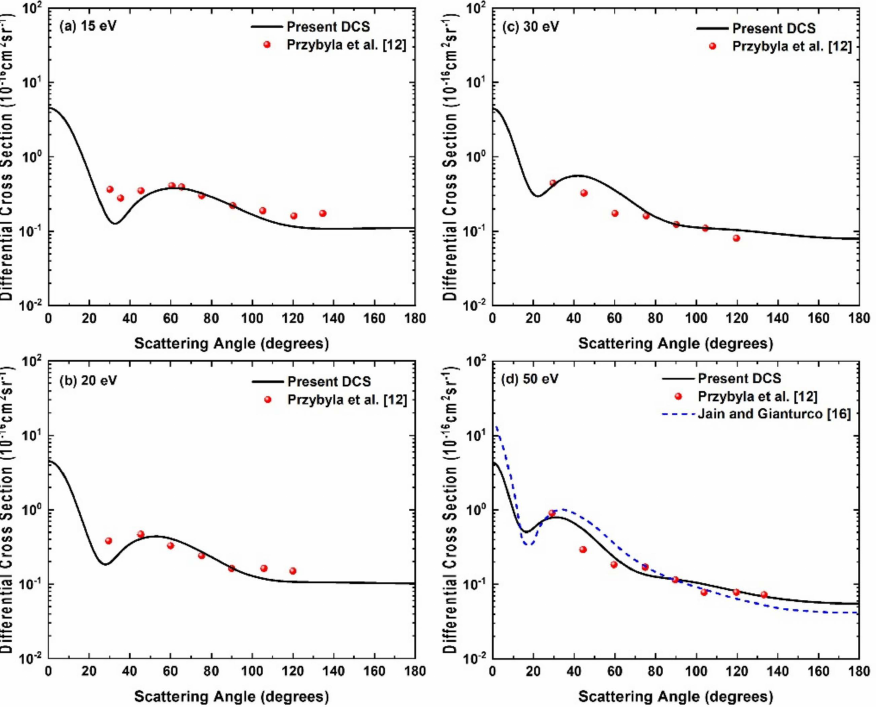
Figure 3. Differential cross sections for positron-CH 4 elastic scattering at incident positron energies ( a ) 15 eV, ( b ) 20 eV, ( c ) 30 eV and ( d ) 50 eV. Solid line, present DCS; dashed line, Jain and Gianturco [16]; solid sphere, Przybyla et al. [12].